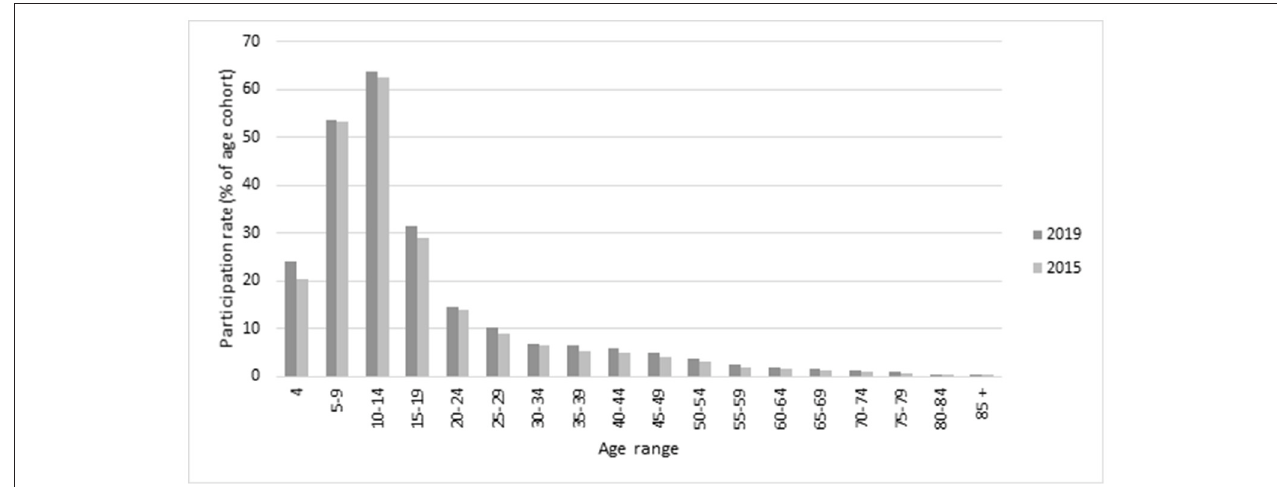
FIGURE 1 | Overall participation rates in 10 sports: 2015 and 2019, Victoria: by age.